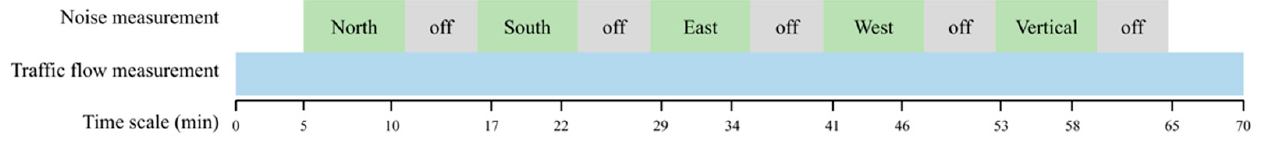
Figure 2. Time scale of noise and traffic flow measurement along with the orientation and state of the microphones.